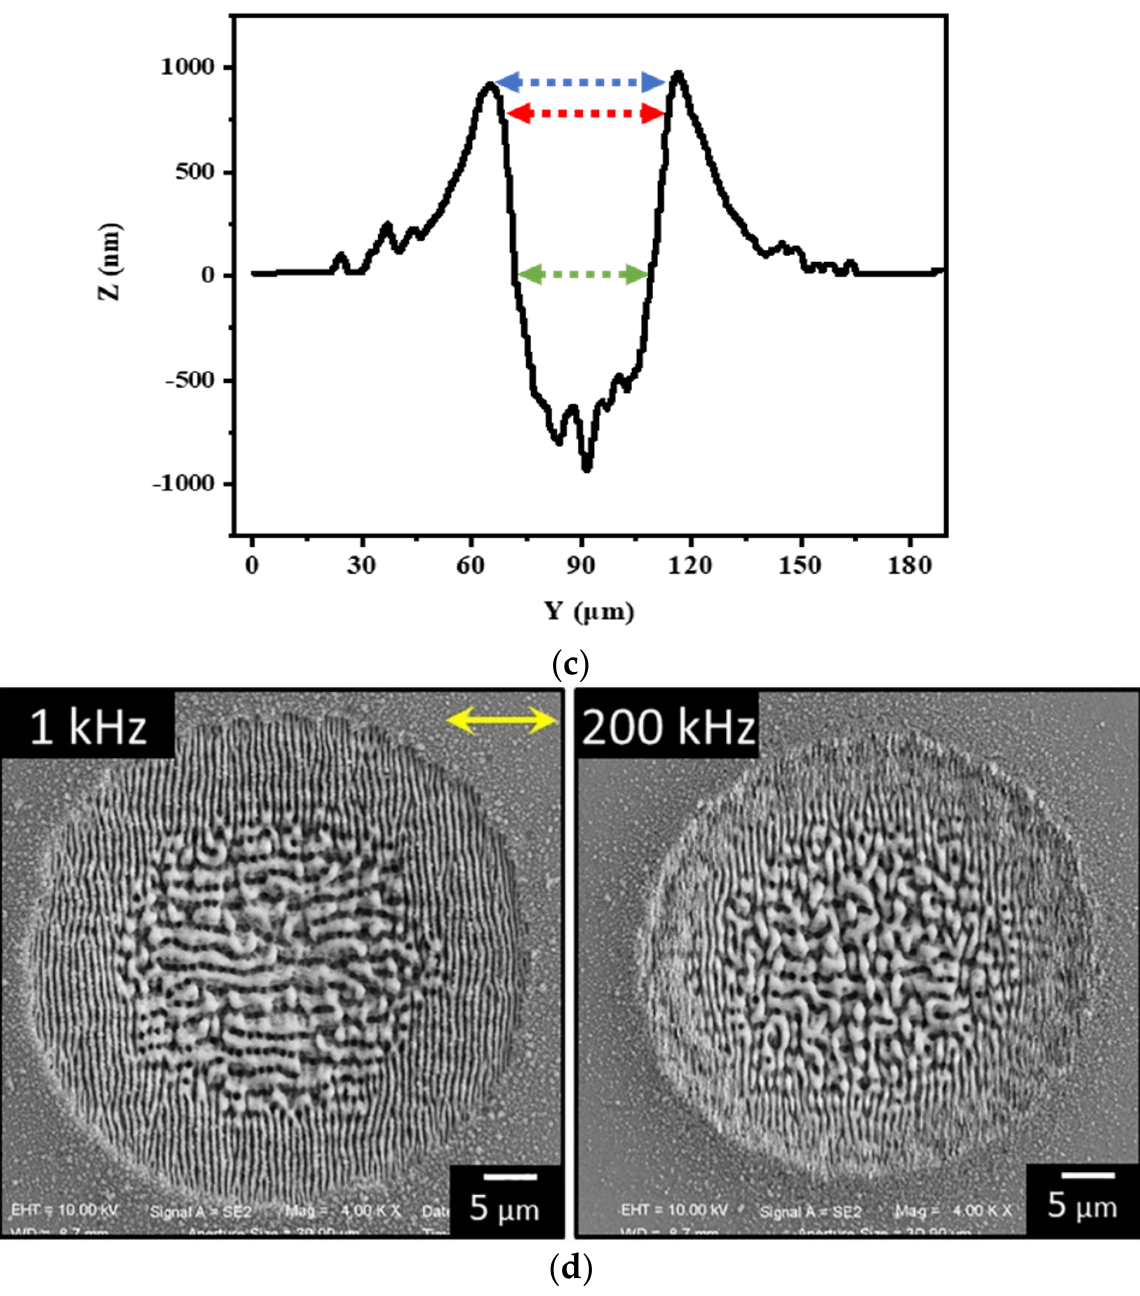
Figure 3. ( a ) Area of the drilled crater with different laser fluences ranging from 100 to 5000, reprinted with permission from [50], copyright from Elsevier 2019; ( b ) impact of laser scanning speed on the heat-affected zone, reprinted with permission from [54], copyright from Elsevier 2017; ( c ) cross-section profile of a crater along a horizontal dashed line, reprinted with permission from [52], copyright from Elsevier 2020; ( d ) SEM images of the irradiated silicone sample with N = 200 pulses at an energy E = 7 µ J, in air, for two different pulse Repetition rate: ( left ) 1 kHz; ( right ) 200 kHz. The yellow arrow in the left panel shows the direction of the laser beam polarization, reprinted with permission from [55]. Copyright from Elsevier 2019.